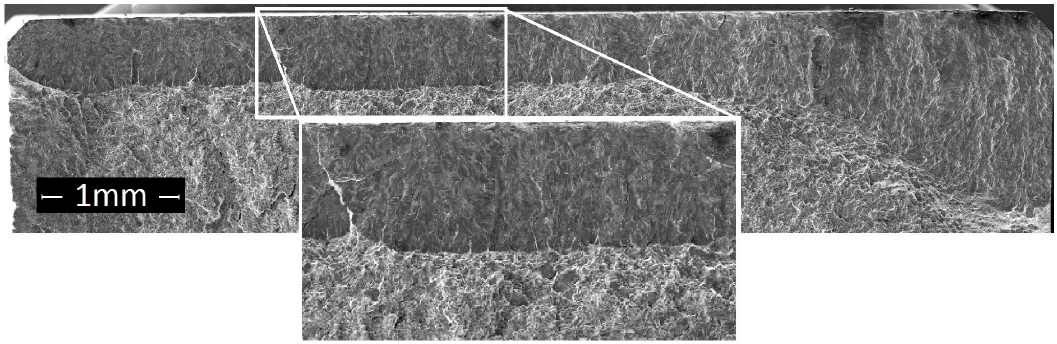
Figure 12. Fracture surface of a specimen with Load Combination 2, without shot peening and a fatigue life of 112,165 cycles.